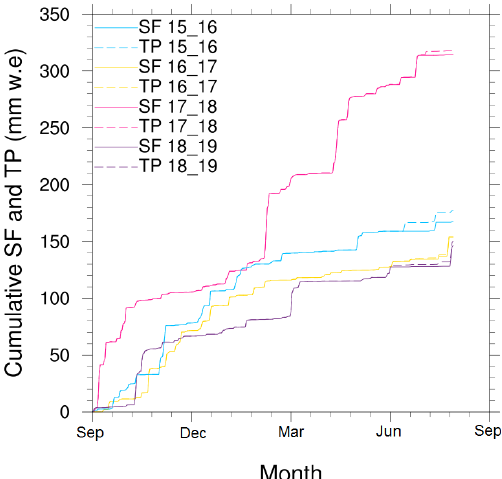
Figure 8. The cumulative total precipitation (TP) and snowfall (SF) from September (beginning of the accumulation season) to August (end of the melt season) at the KPC_L location from